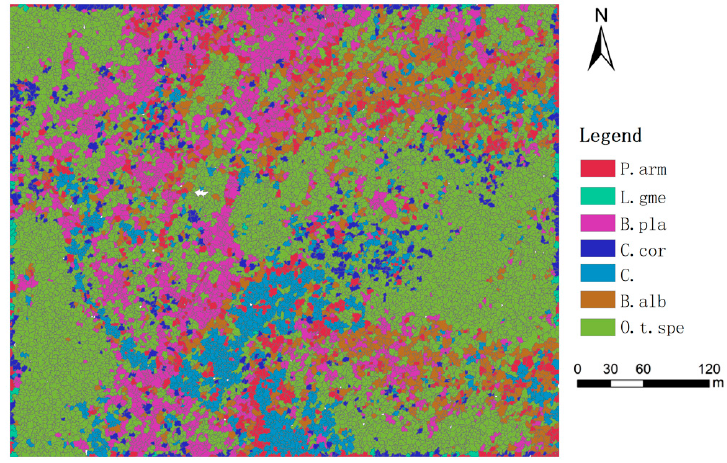
Figure 5. Classification results of tree species at altitude 1600 m based on XGBoost.